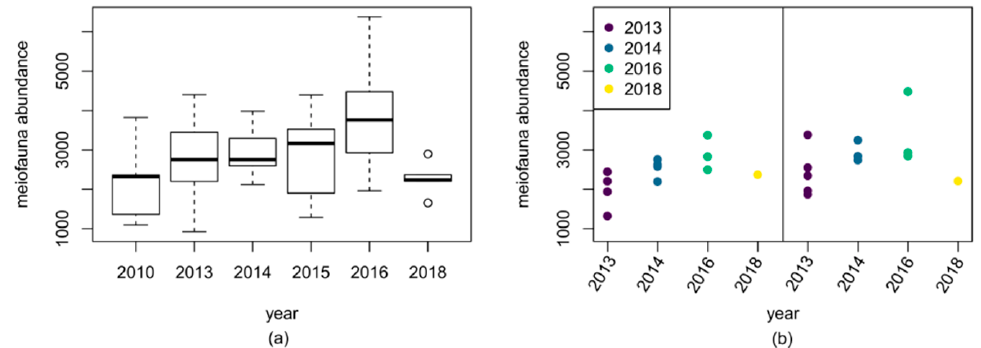
Figure 4. Boxplot of overall meiofauna abundance per 100 cm 2 of sediment in different years, with the middle line being the median, the box referring to the first and third quartile and the whiskers indicating maxima and minima within a 1.5-fold interquartile range; potential outliers are indicated by points ( a ); overall abundance of meiofauna per 100 cm 2 in samples obtained in consecutive years from the two time-series sample sites (see magenta dots in Figure 1: left: northwestern station; right: southeastern station) ( b ).